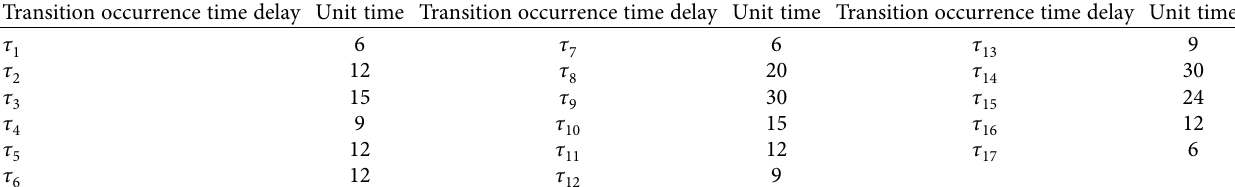
Figure 3: Markov chain. Table 2: Occurrence time delay of each transition.